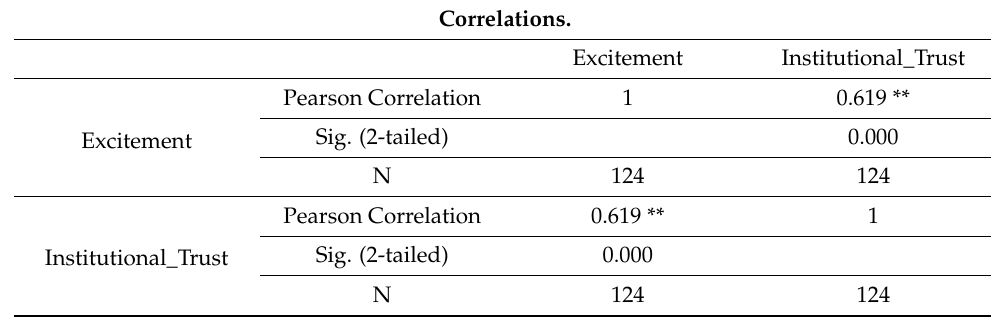
Table 8. Correlation excitement and